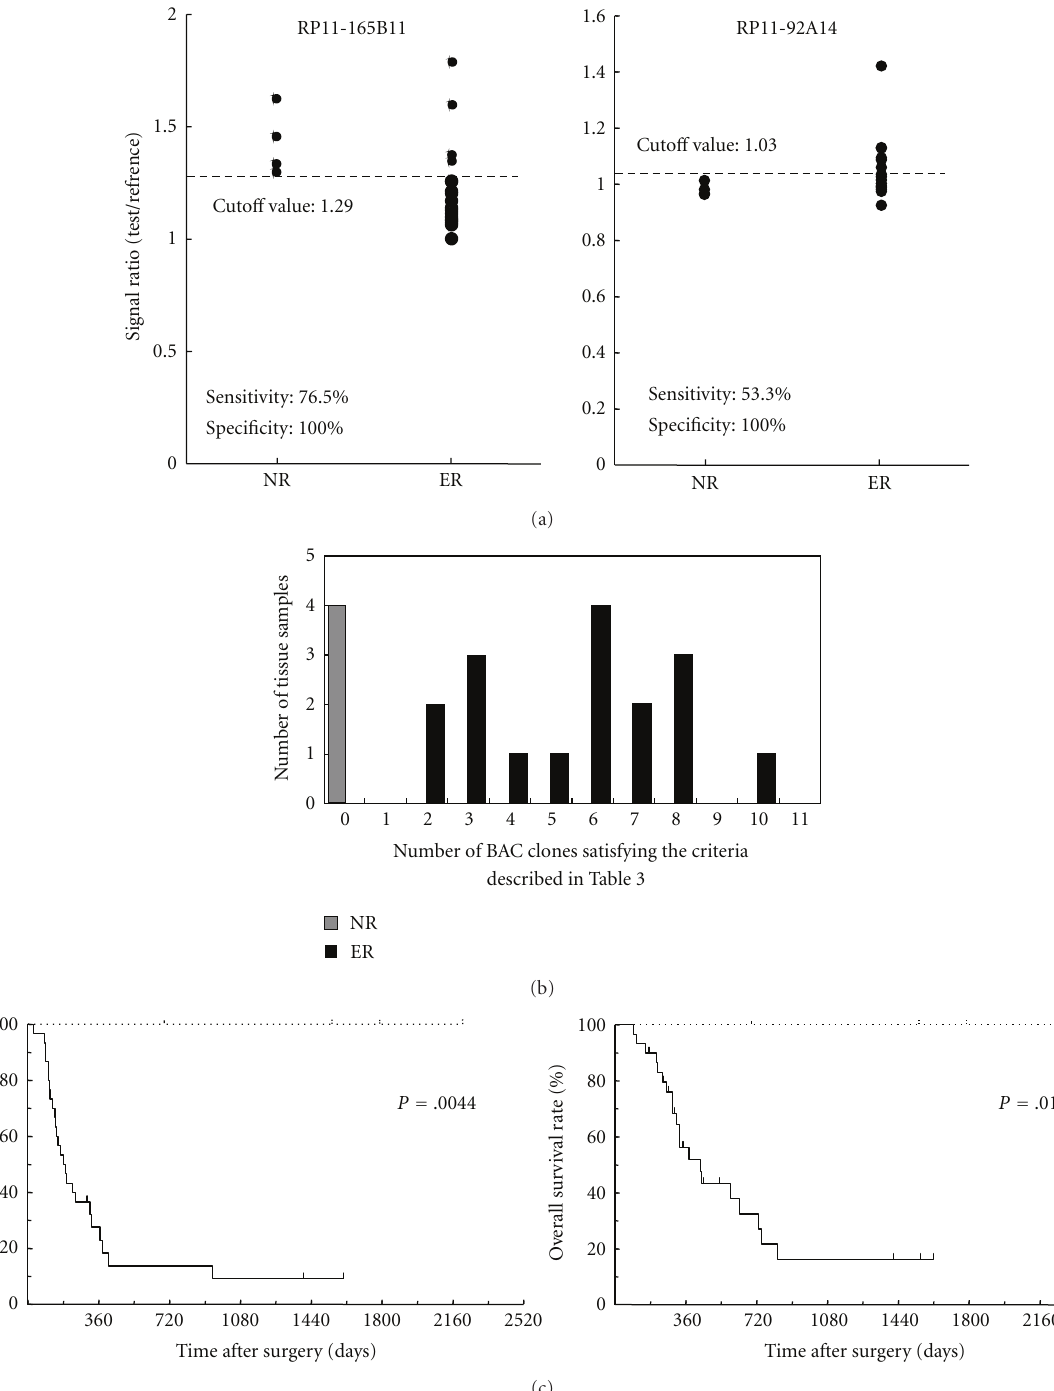
Figure 3: Establishment of criteria for prognostication of patients with ductal adenocarcinomas of the pancreas. (a) Scattergrams of the signal ratios in samples of cancerous tissue obtained from patients in the no-relapse group (NR, n = 4) and early-relapse group (ER, n = 17) who had not undergone adjuvant chemotherapy with gemcitabine after surgery on representative bacterial artificial chromosome (BAC) clones, RP11-165B11 and RP11-92A14. Using the cuto ff values indicated by the dotted lines, patients belonging to the ER-group were discriminated from those belonging to the NR-group in the learning cohort with 100% specificity. (b) Histogram showing the number of BAC clones satisfying the criteria listed in Table 3 for patients belonging to the NR- (shaded column) and ER- (filled columns) groups in the learning cohort. (c) Kaplan-Meier survival curves of 34 patients who had not undergone adjuvant chemotherapy with gemcitabine after surgery in the validation cohort. Both the recurrence-free and overall survival rates of 29 patients satisfying the criteria listed in Table 3 for 2 or more BAC clones (solid lines) were significantly lower than those of 5 patients satisfying the criteria listed in Table 3 for less than 2 BAC clones (dotted lines). Log-rank test ( P = . 0044 and P = . 014,